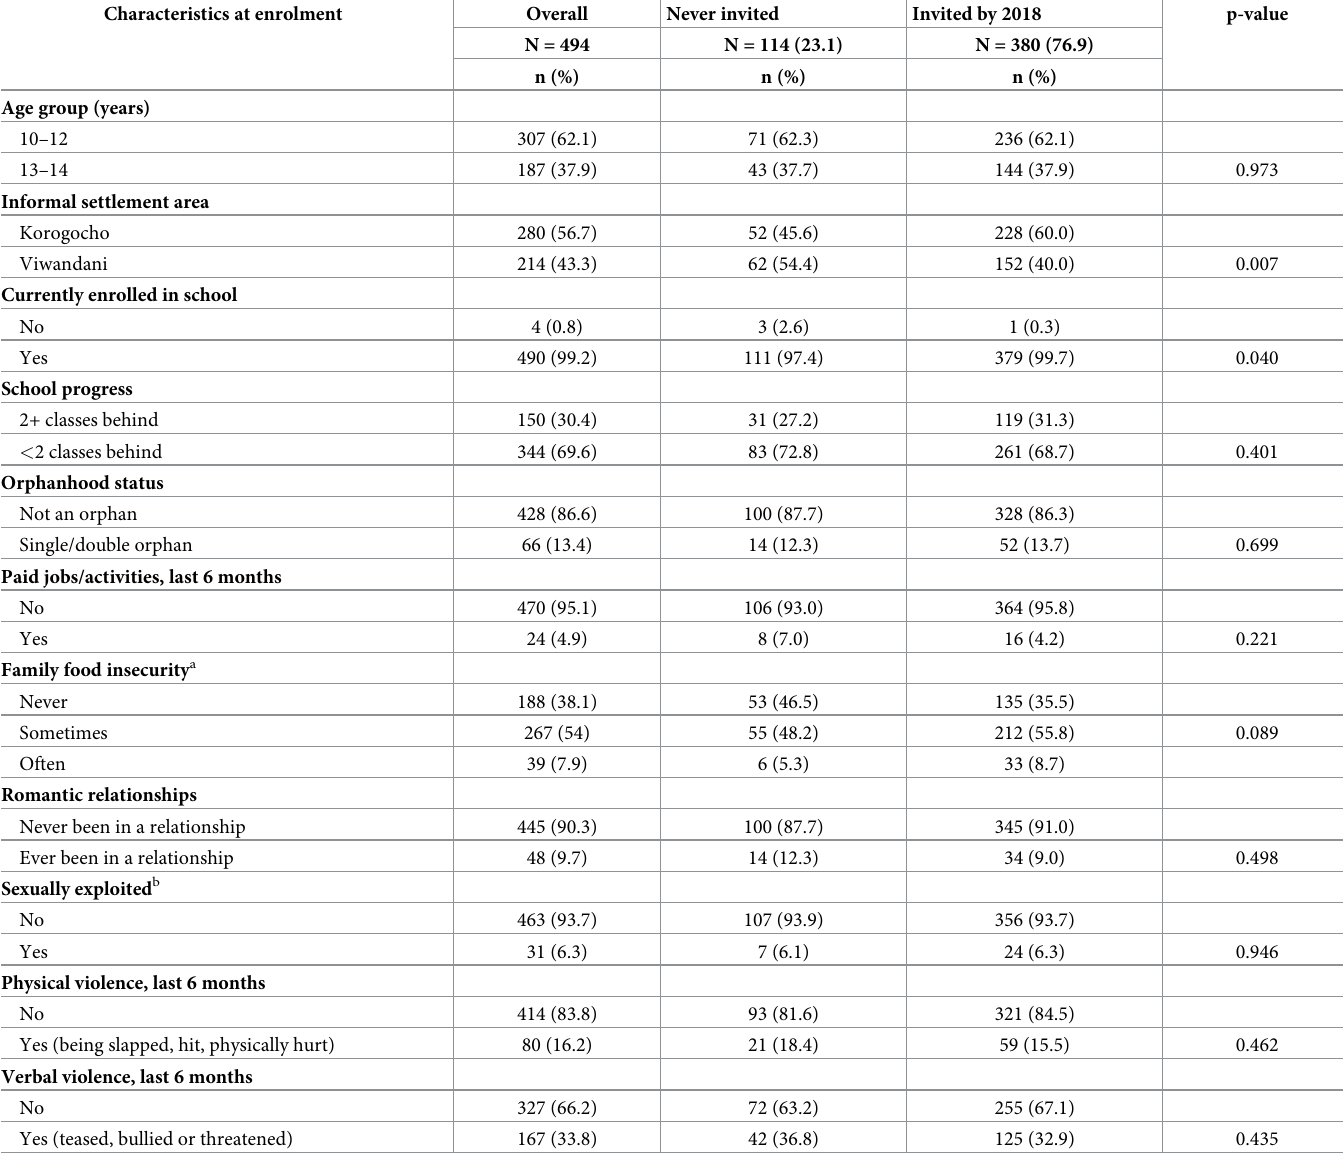
Table 1. Enrolment profile (characteristics at cohort enrolment) among girls aged 10–14 years and followed up in 2019, by invitation to participate in DREAMS. Characteristics at